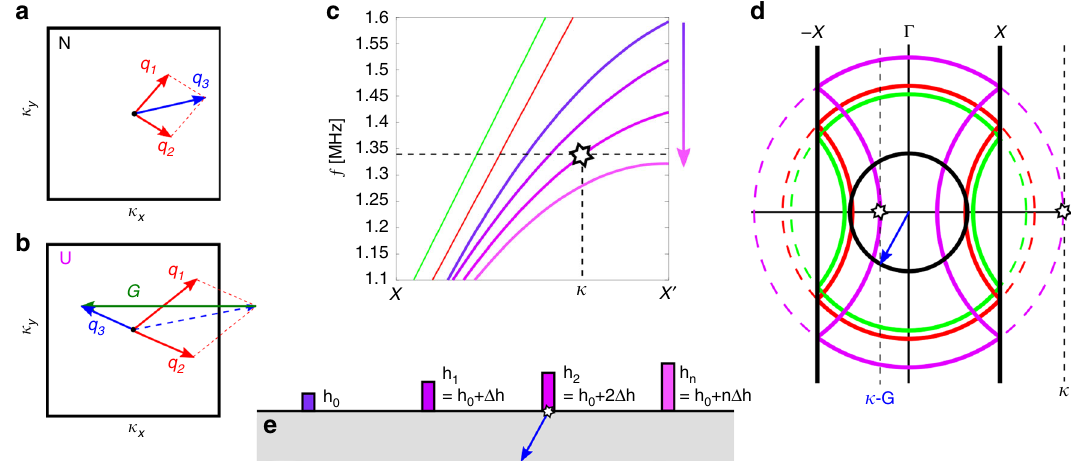
Fig. 2 Theoretical prediction from local dispersion curves. a Wave vector scattering in the fi rst Brillouin zone showing conventional de fi nitions of an N-process and a U-process b ; the ‘ fl ip-over' description is only strictly true for collinear scattering 19 . c Longitudinal dispersion curves within second Brillouin zone; X marks the edge of the fi rst Brillouin zone, whilst X 0 marks the edge of the second Brillouin zone. Each dispersion curve represents the second longitudinal mode for a perfectly periodic array of rods, with the fi xed heights with R(S) sound lines shown in red(green). d Isofrequency contours of rod where last longitudinal mode supported, after which an effective bandgap is reached, when exciting at a frequency of 1.340 MHz. At this position U-processes are preferential to a change in rod motion and, resulting in an effective reversed wavenumber κ − G , capable of mode converting into a P wave (black isofrequency contour, shown in full dispersion curves in Supplementary Fig. 1). e Graded array schematic colours corresponding to the curves in c .